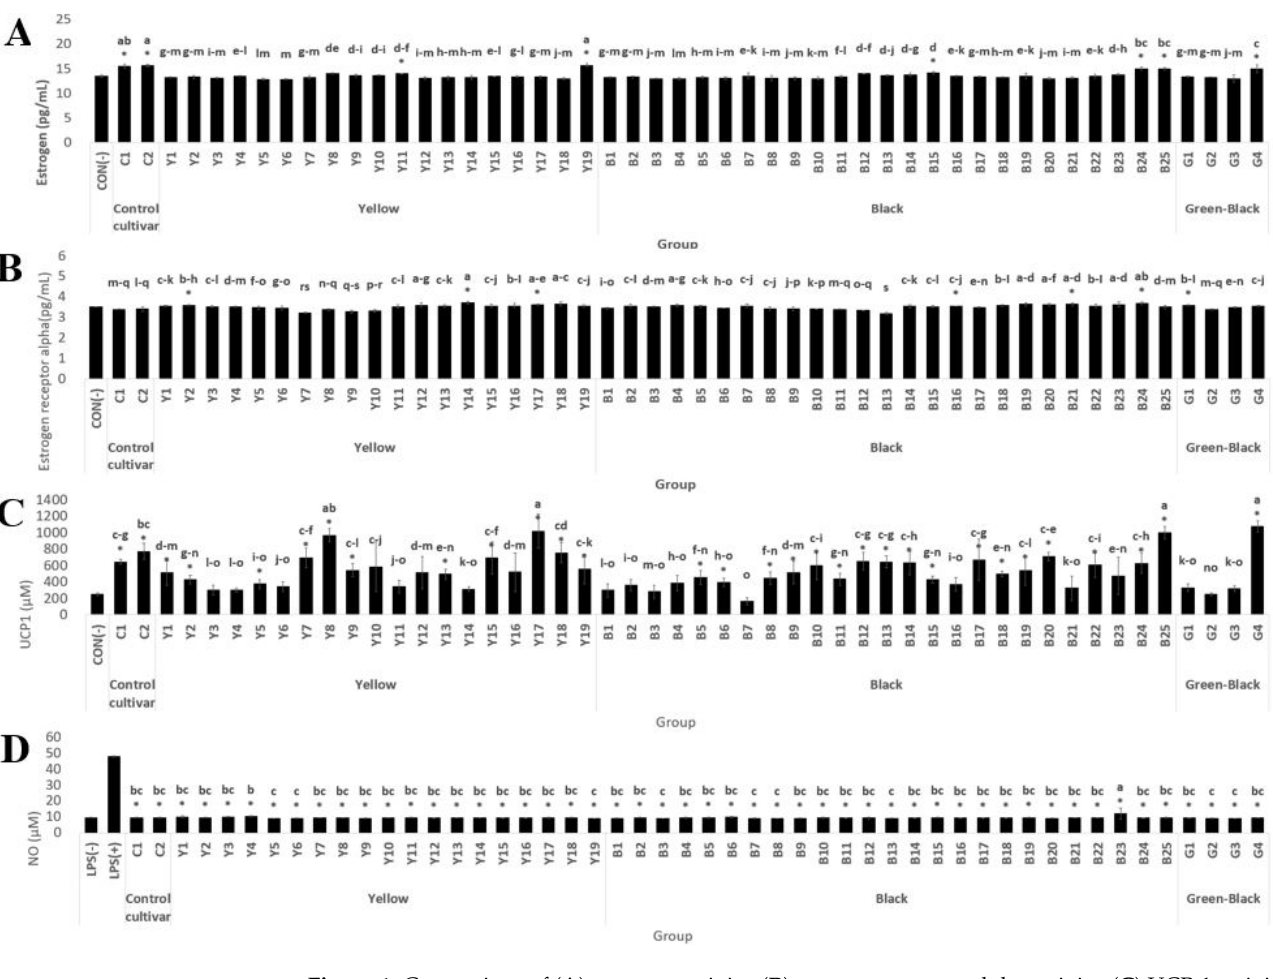
Figure 1. Comparison of ( A ) estrogen activity, ( B ) estrogen receptor alpha activity, ( C ) UCP-1 activity, ( D ) NO inhibition activity by soybean seed coat color. a–s Means followed by the same letter within rows are significantly different at p < 0.05, Duncan’s multiple range test. * Significantly different from CON and LPS (+) at p < 0.05.